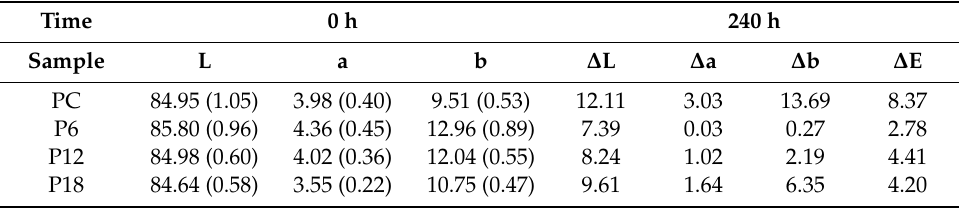
Table 4. The color change of untreated and esterified wood after 240 h of UV irradiation. Time 0 h 240 h Sample L a